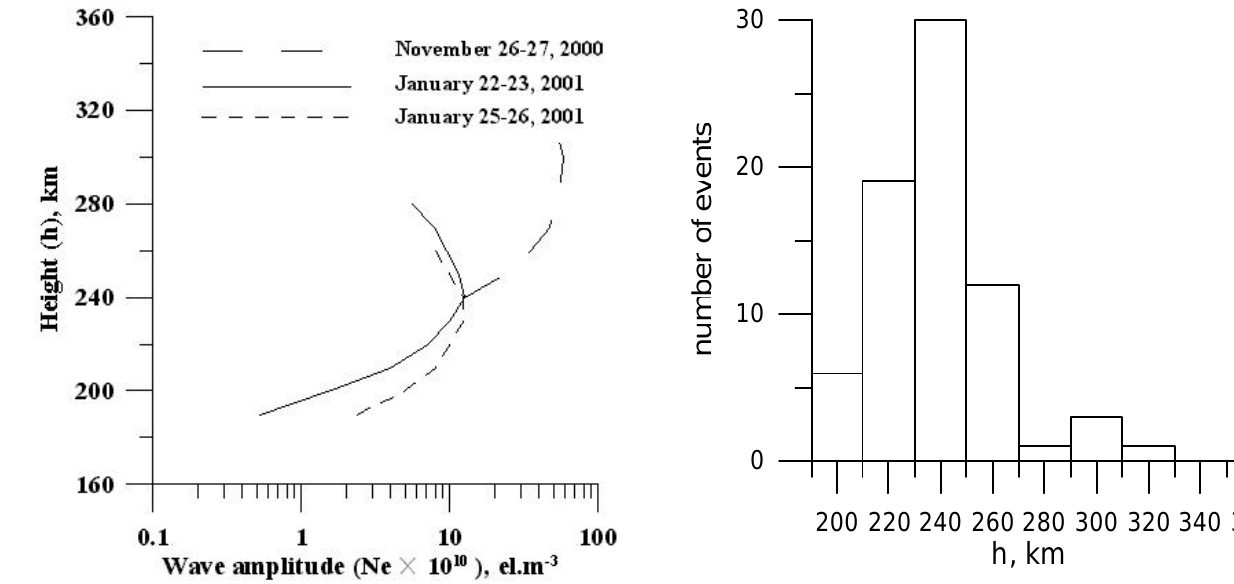
Fig. 6. Wave amplitude height profiles for three nights with differ- ent magnetic activity: 26–27 November 2000 ( 6K p = 28); 22–23 January 2001 ( 6K p = 22); 25–26 January 2001 ( 6K p = 23).